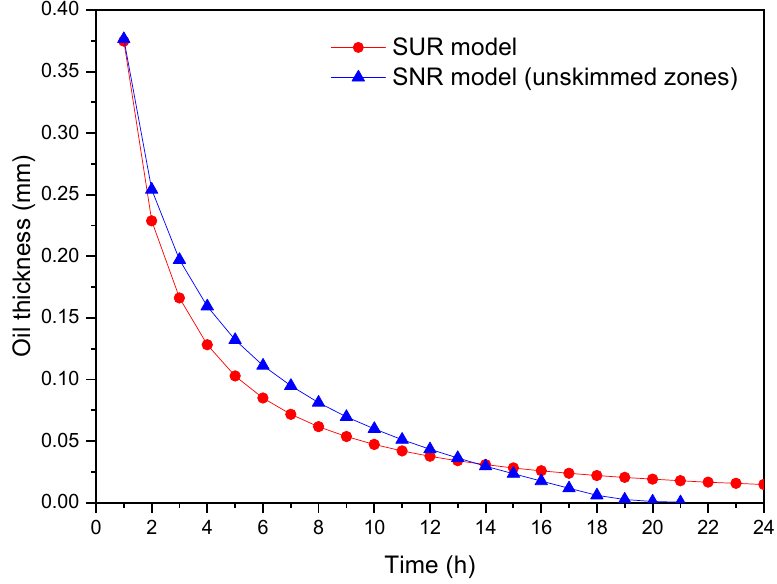
Figure 9. Comparison of oil thickness in the SUR model and the SNR model for 24 h.